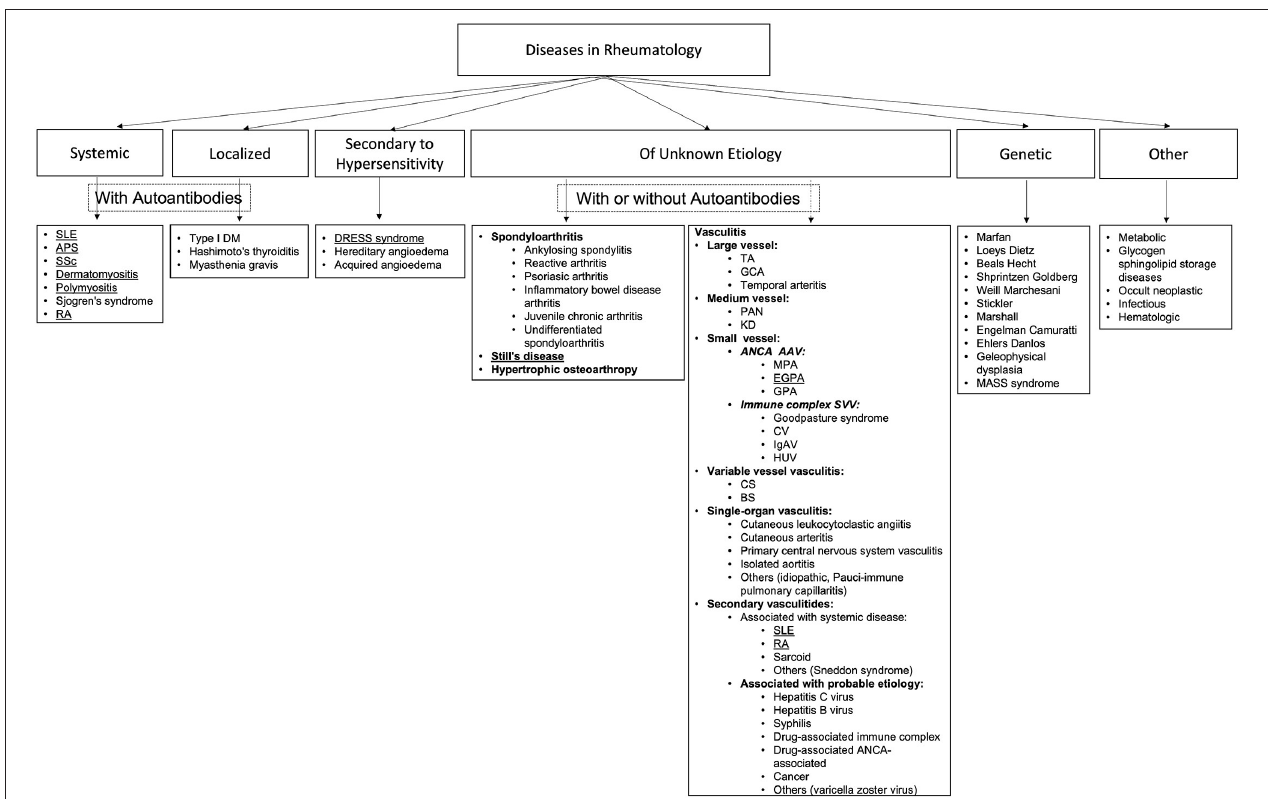
FIGURE 1 | Algorithm of representative rheumatological disorders. This figure shows an algorithm created using the published literature that includes most rheumatological disorders. The algorithm is divided into six big categories as systemic and localized (both with autoantibodies), one group secondary to hypersensitivity, another large group of diseases of unknown etiology (with or without autoantibodies) which mainly involve spondyloarthropathies and vasculitides (34), one group of genetic origin and finally a group of other sub-groups of disorders such as those related to neoplasias, infectious and metabolic diseases. By looking at the algorithm, it is comprehensive that one general review paper could not go into detail for each component. Therefore, we chose to describe the most frequent diseases with known cardiovascular involvement from the systemic with autoantibodies groups, such as those underlined ones—one representative illness of the group of spondyloarthropathies and one from the group of vasculitides. Finally, one infrequent, maybe underdiagnosed disease such as the DRESS syndrome from the group of diseases secondary to hypersensitivity. SLE, systemic lupus erythematosus; APS, antiphospholipid syndrome; SSc, systemic sclerosis; RA, rheumatoid arthritis; DM, diabetes mellitus; TA, Takayasu arteritis; GCA, giant cell arteritis; PAN, polyarteritis nodosa; KD, Kawasaki disease; ANCA AAV, Antineutrophil cytoplasmic antibody (ANCA)-associated vasculitis (AVV); MPA, microscopic polyangiitis; EGPA, eosinophilic granulomatosis with polyangiitis (formerly